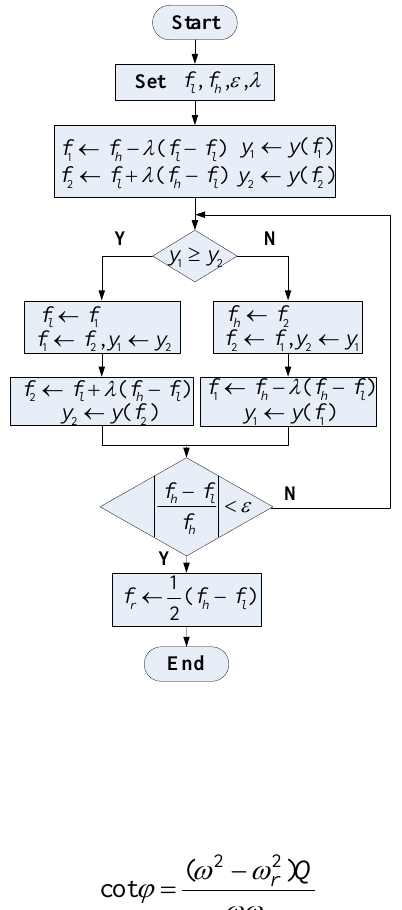
Figure 5. The flowchart of the applied one dimension search